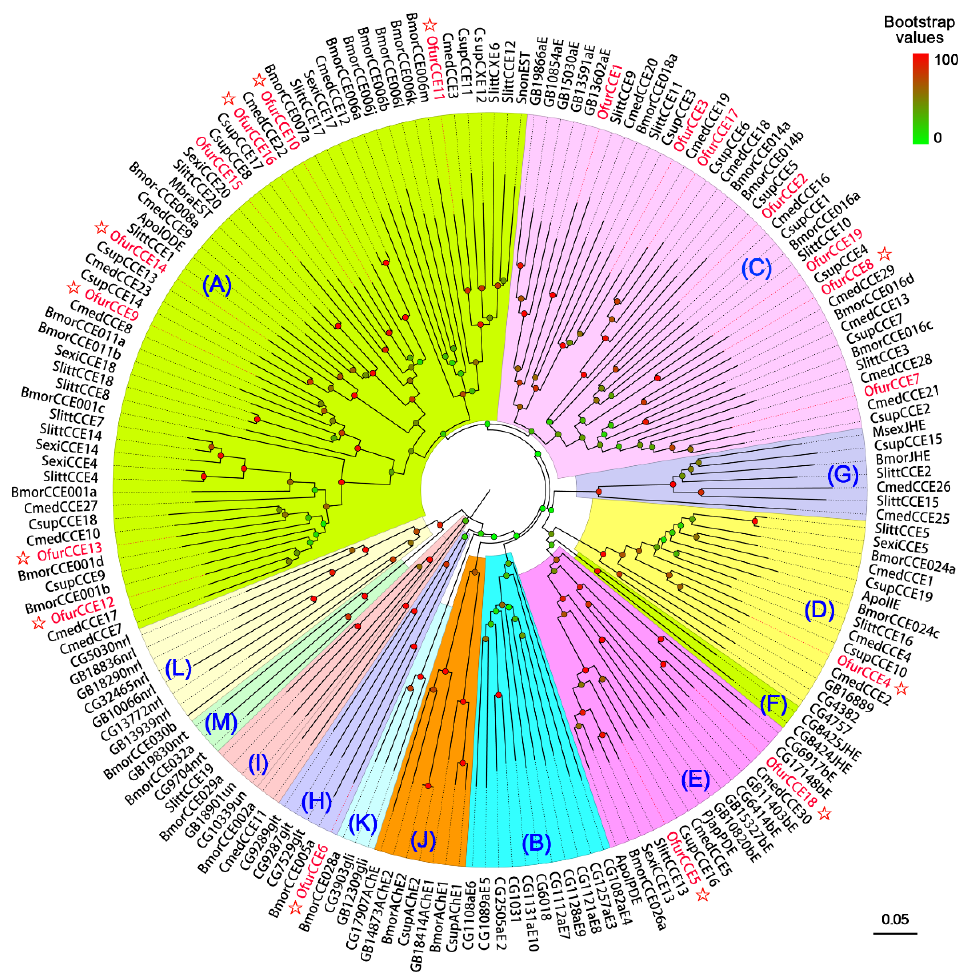
Figure 2. Phylogenetic analysis of CCEs from Ostrinia furnacalis and other insect species including Drosophila melanogaster (Accession numbers refer to FlyBase (CG-prefix)), Apis mellifera (Accession numbers refer to BeeBase (GB-prefix)), Bombyx mori (Bmor), Cnaphalocrocis medinalis (Cmed), Spodoptera littoralis (Slitt), Spodoptera exigua (Sexi), Manduca sexta (Msex), Antheraea polyphemus (Apol), Mamestra brassicae (Mbra), Sesamia nonagrioides (Snon), Chilo suppressalis (Csup), and Popilia japonica (Pjap). Bootstrap values are indicated by colors from green (0) to red (100). The CCEs are